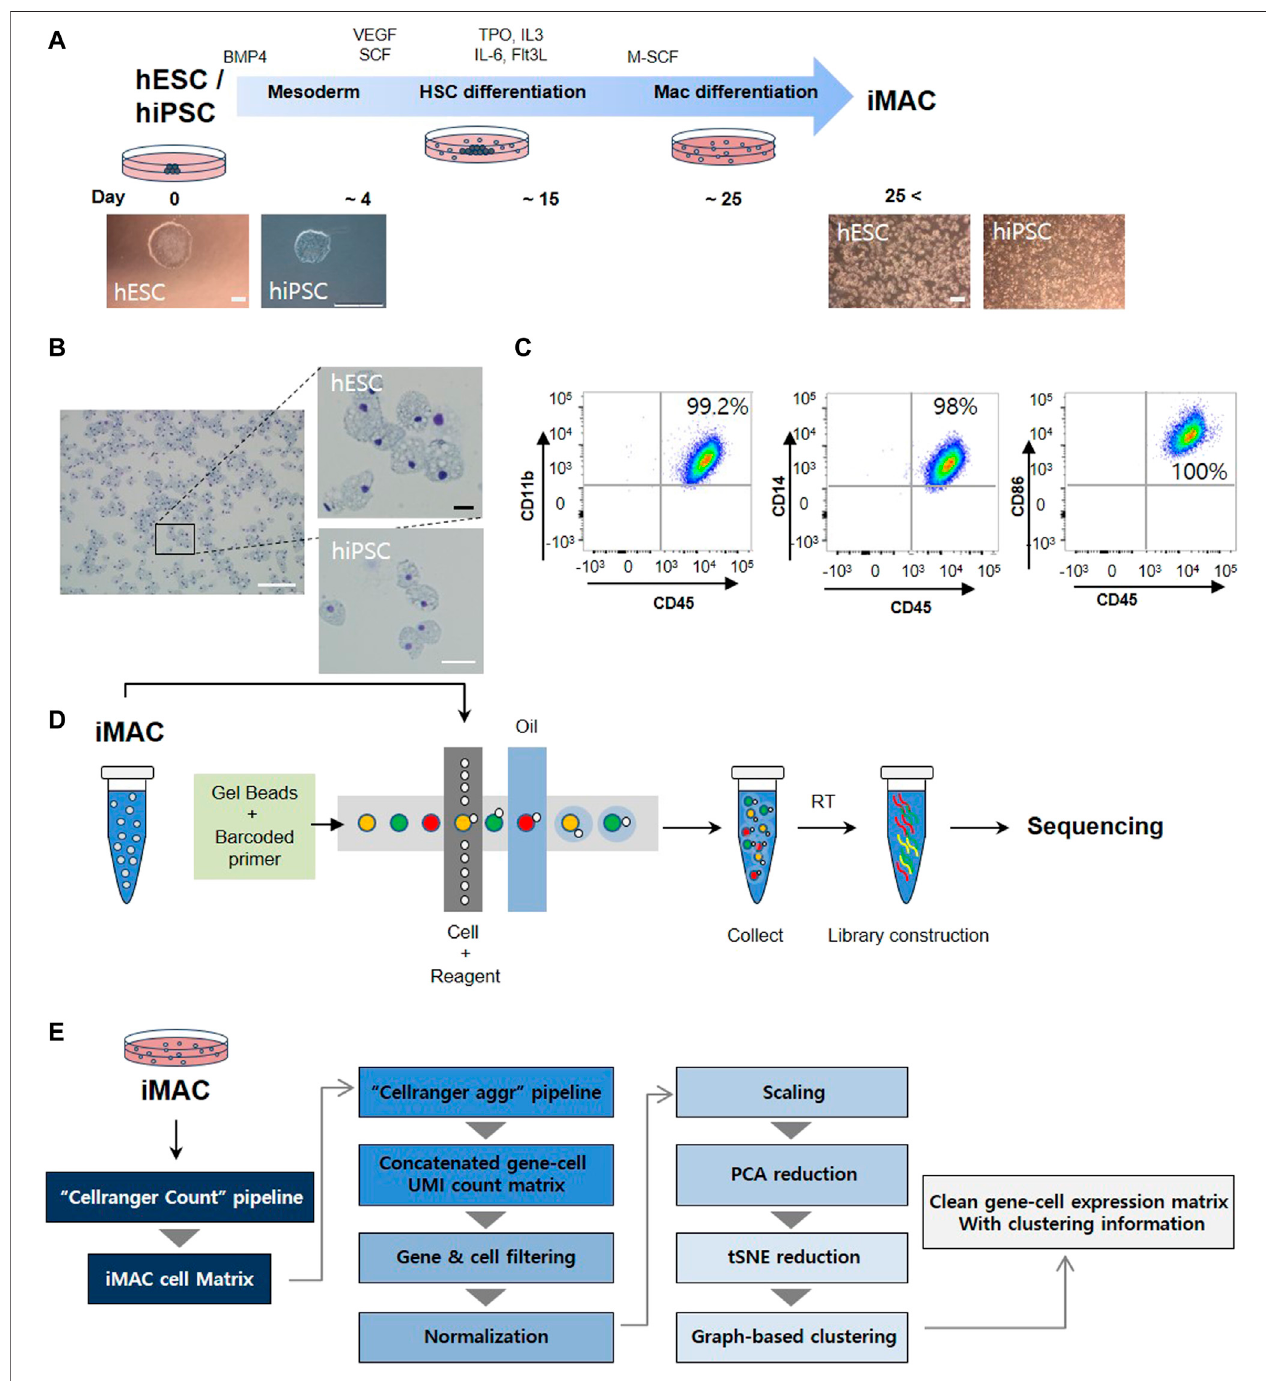
FIGURE 1 | Overview of the study protocol. (A) A schematic representation of cell differentiation from human embryonic stem cells (hESC) or human induced pluripotent stem cell (hiPSC) to macrophages. (B) Typical morphologic features of macrophages from hESC and hiPSC are shown. (C) Macrophage markers (CD14, CD11b, CD86, and CD45) con fi rmed in hESC derived iMAC via fl ow cytometry. (D) Macrophage single-cell RNA sequencing libraries were generated using the Illumina HiSeq 4000 platform. (E) Pipeline for single-cell RNAseq analysis. Scale bar: white (cid:2) 200 μ m, black (cid:2) 25 μ m.